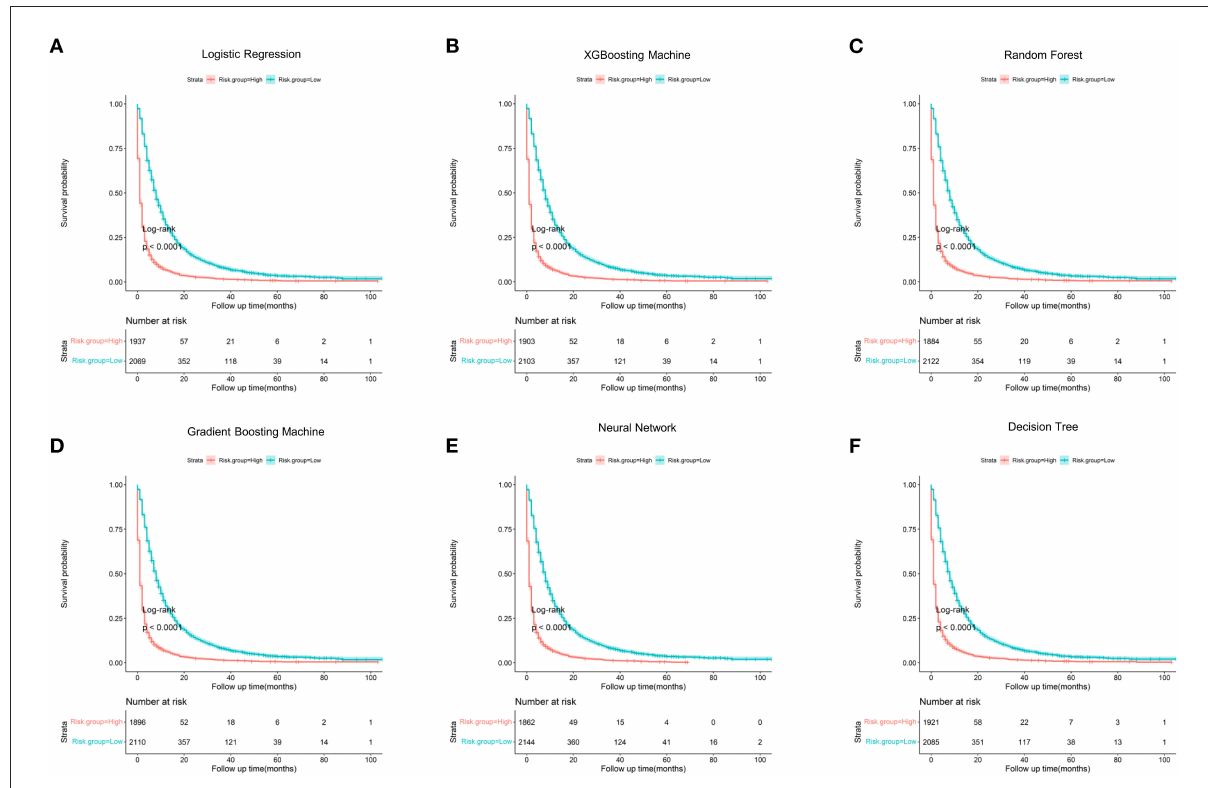
FIGURE6 Kaplan-Meier survival curves stratified by risk group (All P < 0.001, log-rank test). (A) Logistic Regression; (B) XGBooting Machine; (C) Random Forest; (D) Gradient Boosting Machine; (E) Neural Network; (F) Decision